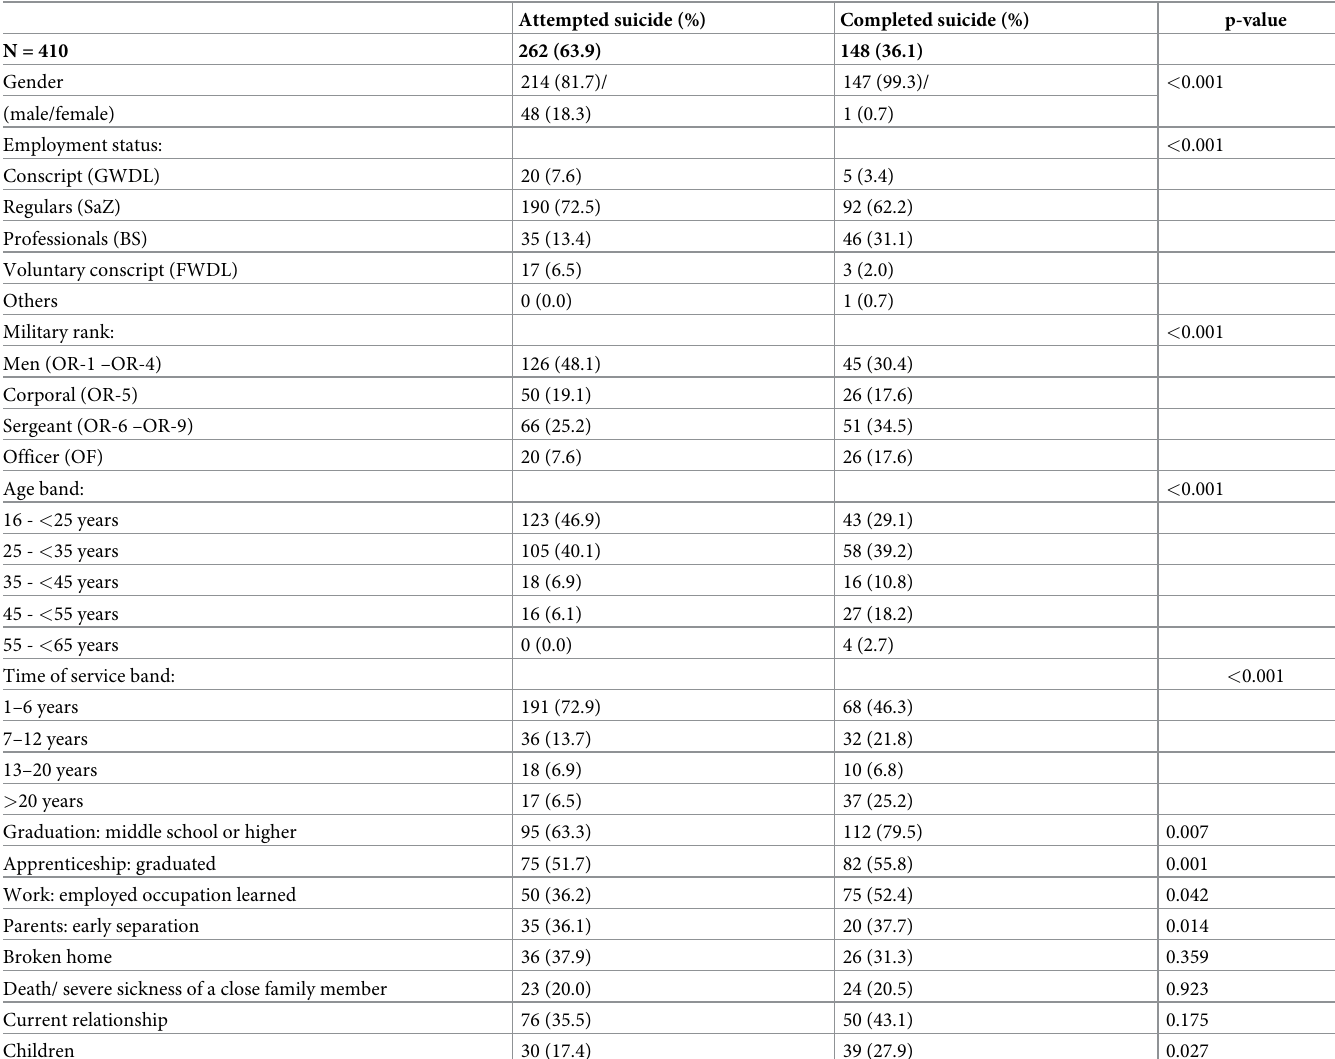
Table 1. Socio-demographic